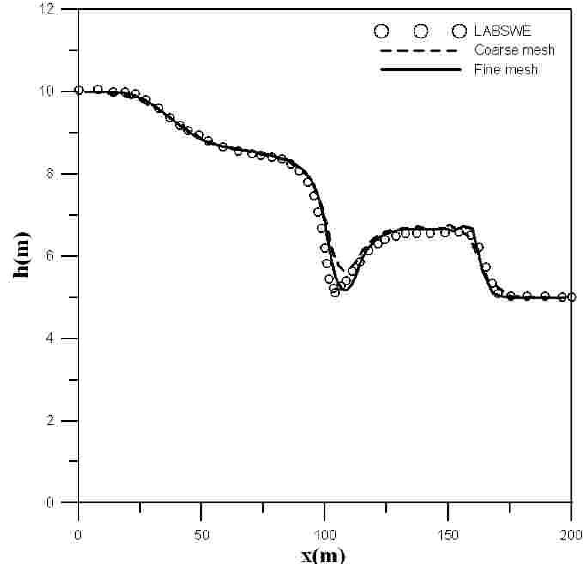
Figure 12. Surface elevation downstream the partial dam break simulated using the present model and compared with the predicted result of LABSWE [42].